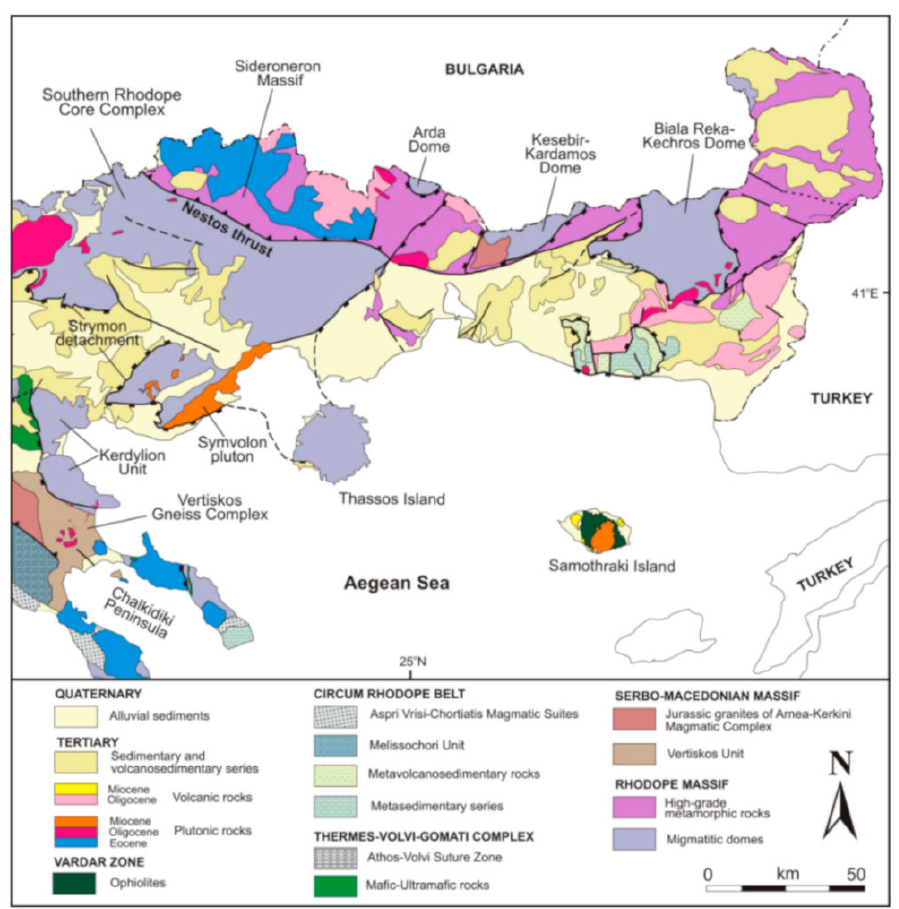
Figure 1. Geological map and regional tectonic framework of northern Greece, modified after Melfos and Voudouris